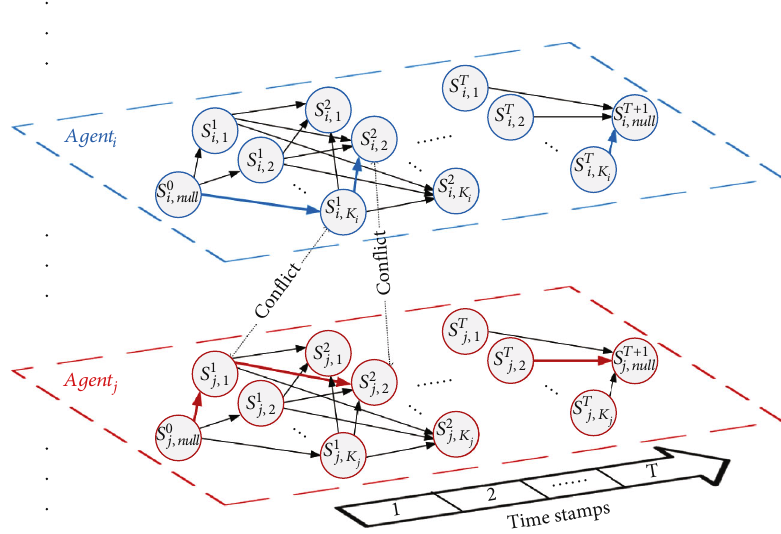
Figure 2: The multiple directed graph model of agents and an example of con fl icts between agent i and agent j